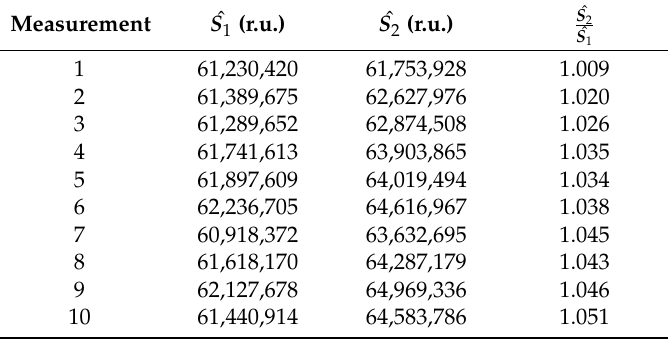
Table 1. Averaged amplitudes of the signal for lasers operating at 3.42 µ m and 3.55 µ m. Measurement ˆ S 1